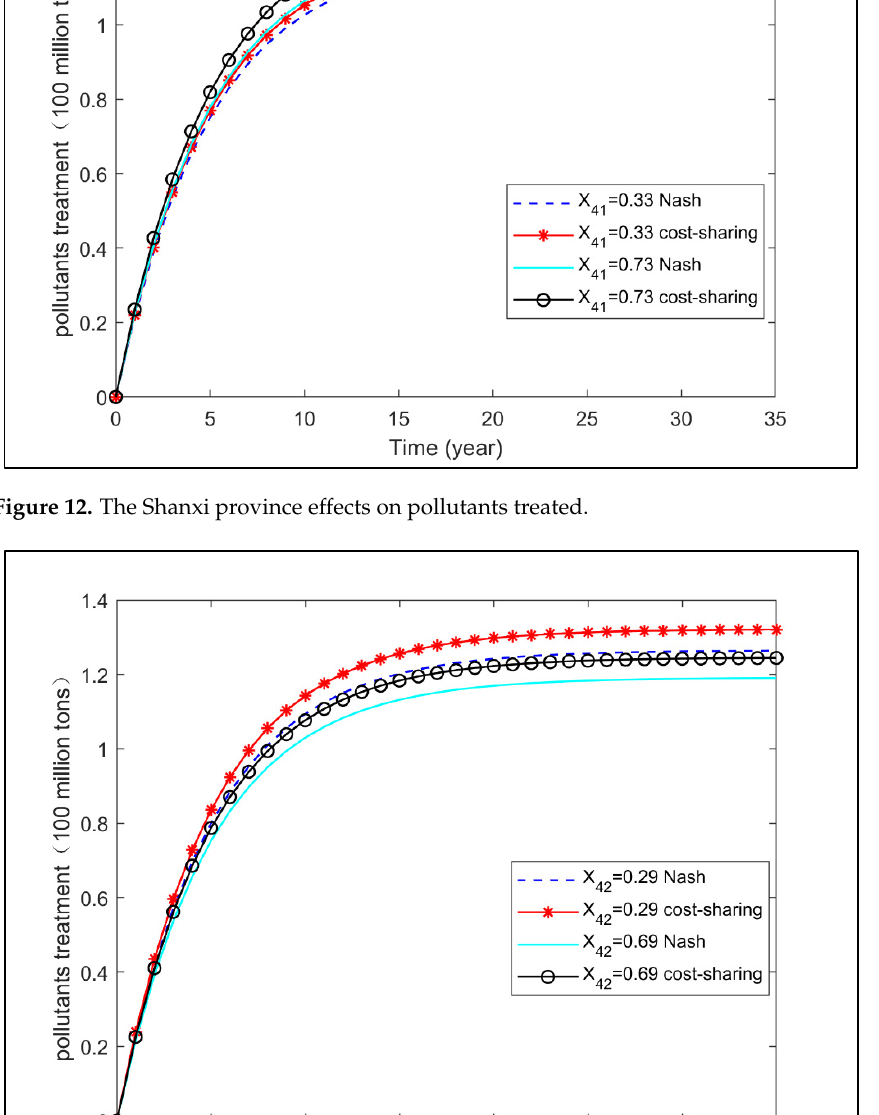
Figure 13. The Shaanxi province effects on pollutants treated.